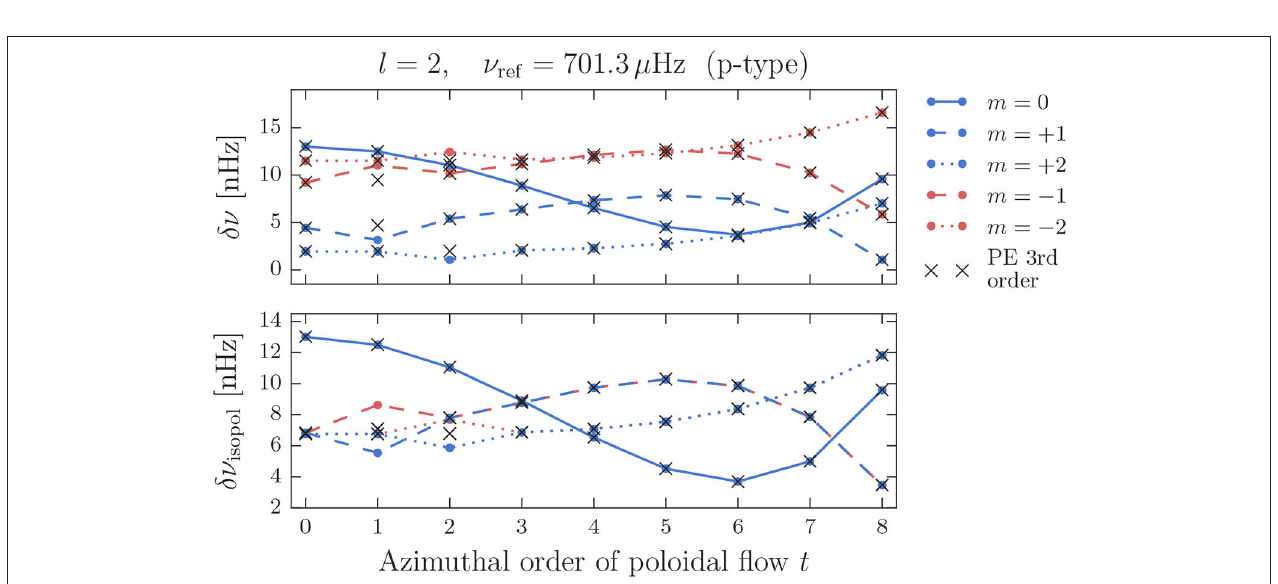
FIGURE 7 | Frequency shifts for the g-type l 2 multiplet at 659.3 µ Hz in the co-rotating frame. (Upper) Shifts resulting from rotation combined with a poloidal flow = of s 8 and different values of t . (Lower) Isolated frequency shifts of the poloidal flow. =